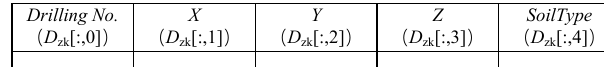
Table 1 . Borehole data format